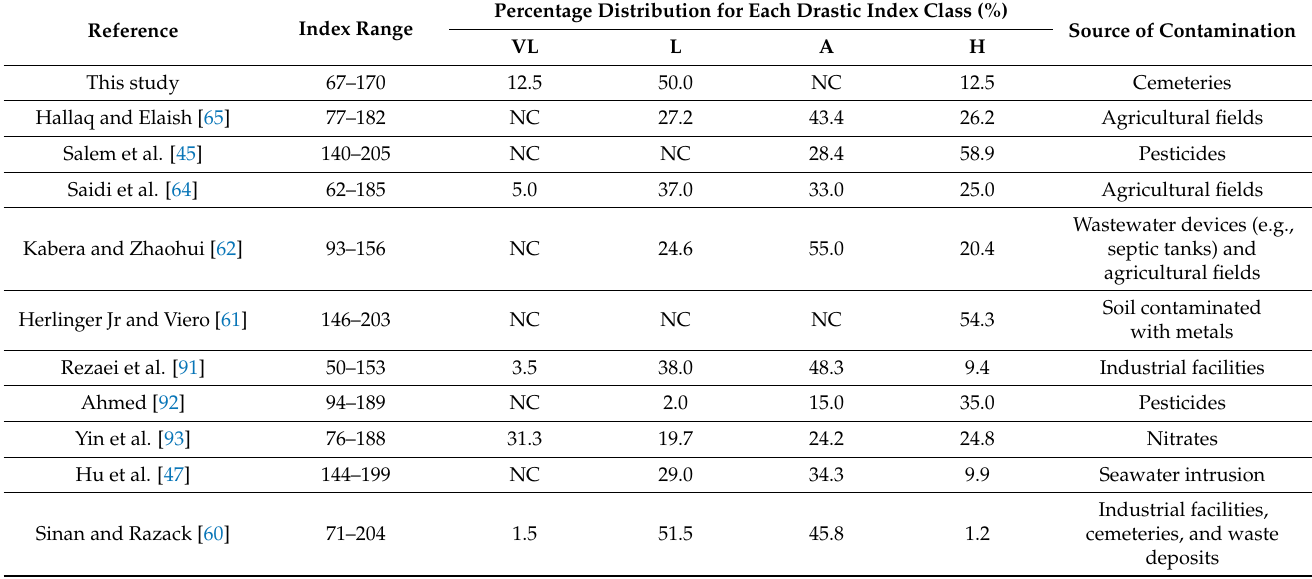
Table 5. Drastic index values in studies with different pollution